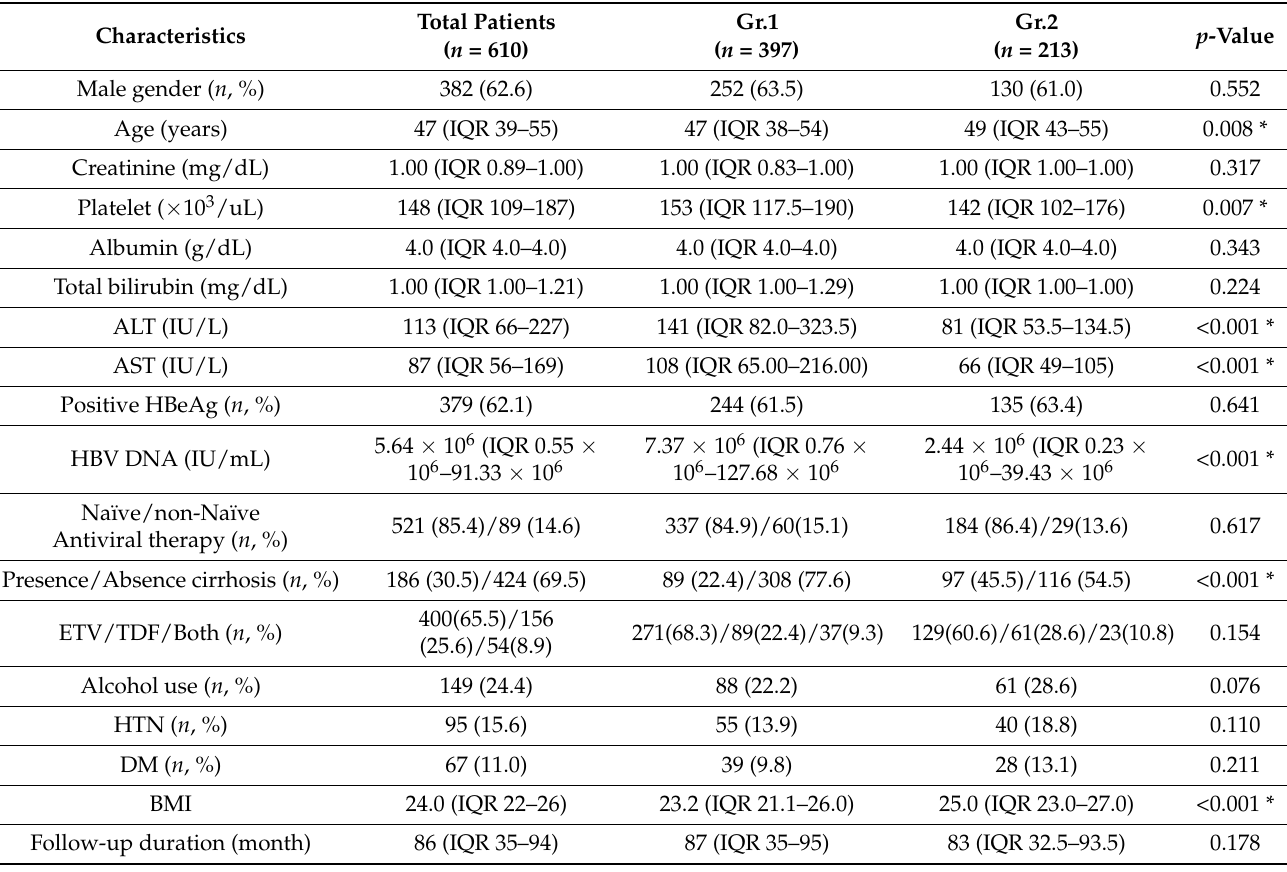
Table 1. Comparison of demographic characteristics of patients with CHB -with ALT normalization (Gr.1) or –without ALT normalization (Gr.2) within 1 year of potent antiviral